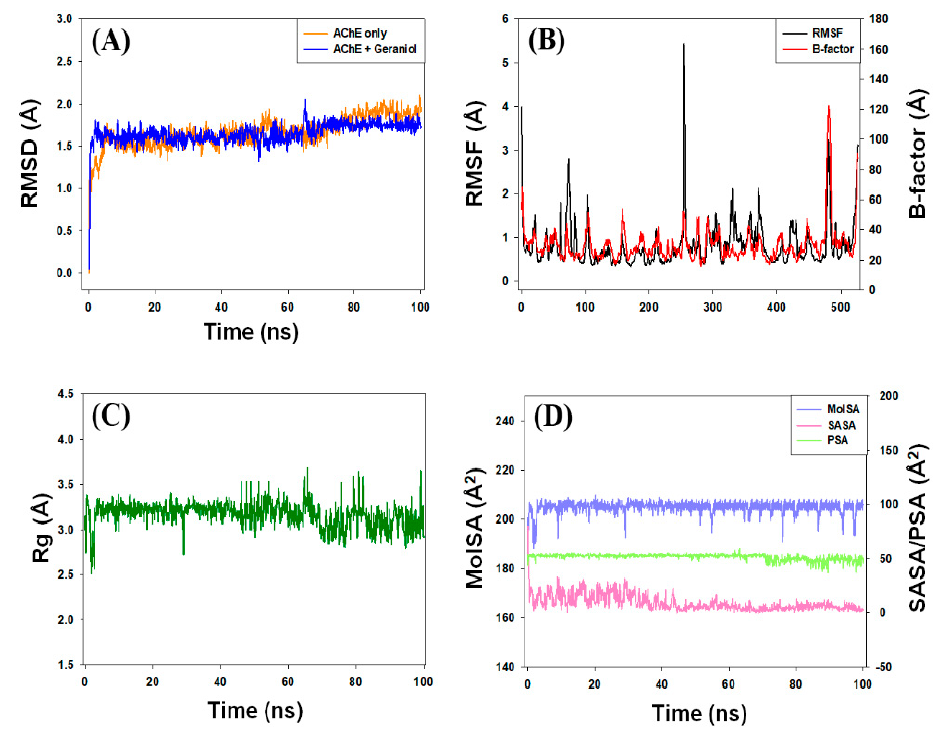
Figure 6. ( A ) Behavior of root-mean-square deviation (RMSD) of AChE, the target protein, in presence (complex) and absence of geraniol; ( B ) average root-mean-square fluctuation (RMSF) values of AChE, in the presence of geraniol; ( C ) the variation in Rg of complex of geraniol bound with AChE protein ( D ) MolSA, SASA, and PSA of complex of target protein AChE bound to geraniol.